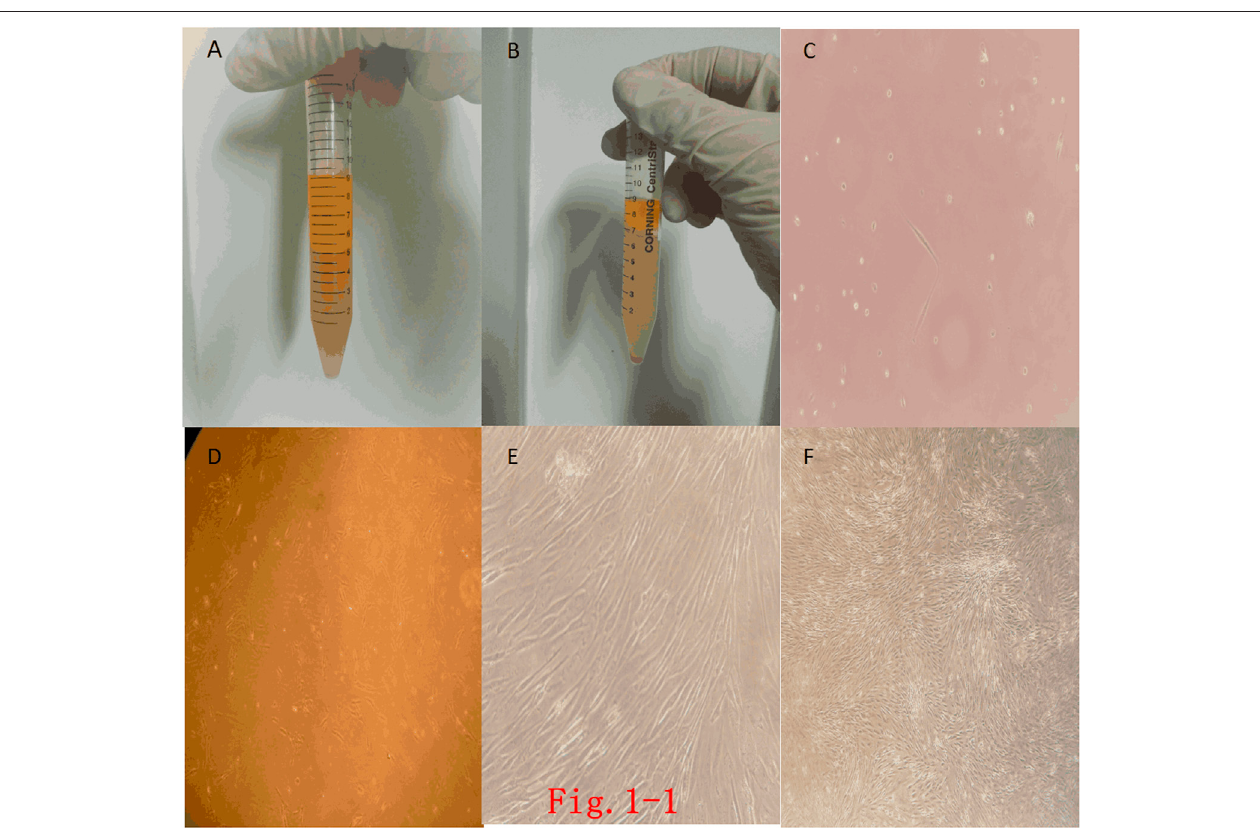
FIGURE 1 | (i) . Fat digestion and morphology of Adipose Tissue – Derived Mesenchymal Stem Cells (Ad-MSCs). (A) : Fat mixed with type I collagenase. (B) : Complete digestion of fat by type I collagenase and centrifugation. (C) : Primary Ad-MSCs at 48 h ( × 200). (D) : Ad-MSCs at 5 days ( × 100). (E) : Ad-MSCs at 15 days ( × 100). (F) : P2-generation Ad-MSCs ( × 40). (ii) . Ad-MSC immunophenotyping. (A) : CD29-positive expression. (B) : CD31-negative expression. (C) : CD90-positive expression. (D) : CD34-negative expression. (E) : CD45-negative expression. (F) : CD166-positive expression. (G) : HLA-DR-negative